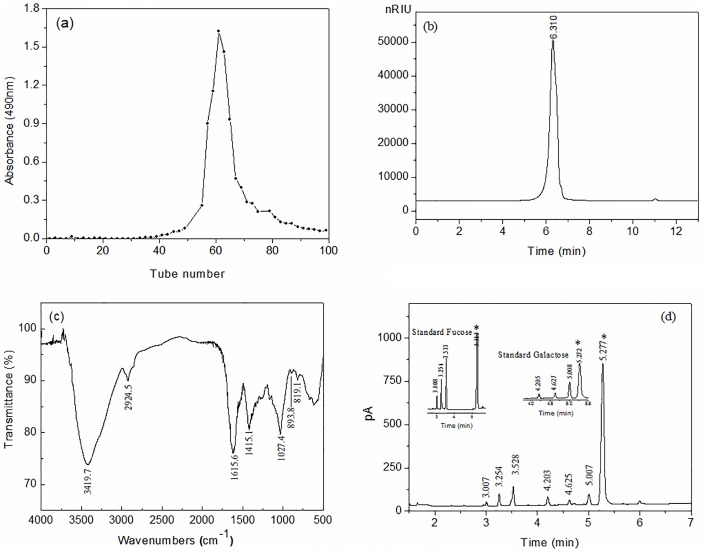
(a) Sugar curves of STSP-I from DEAE Sepharose CL-6B column chromatogram, (b) HPSEC chromatogram of STSP-I with a RID detector, (c) IR spectrum of STSP-I, and (d) GC chromatograms of TMCS derivative products from hydrolyzed STSP-I and standard samples.In the GC chromatograms, asterisks indicate the internal standard mannitol.